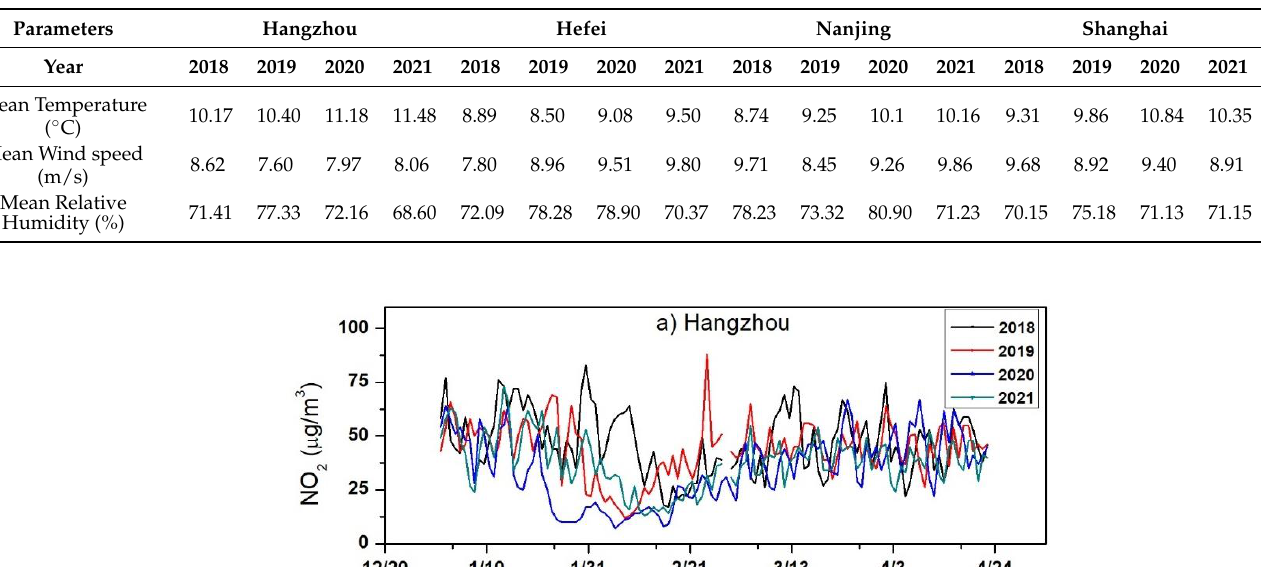
Table 1. Mean values of meteorological parameters (1 January to 25 April) at typical cities in YRD region.